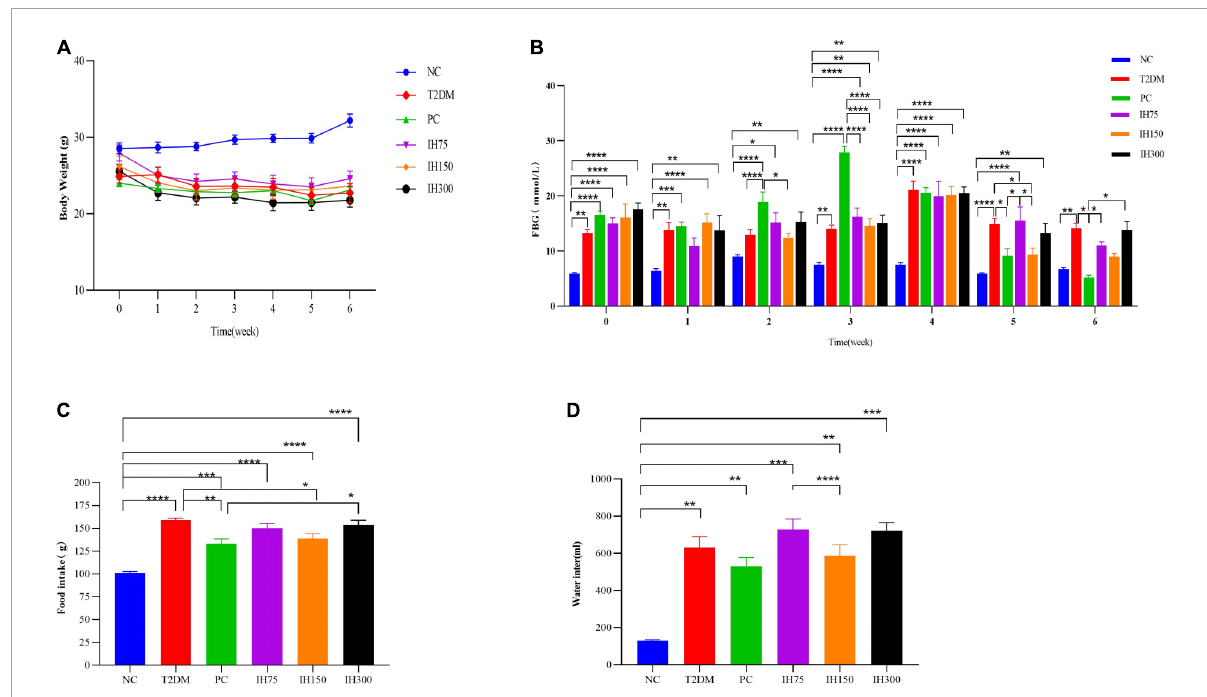
FIGURE1 Effects of isorhamnetin (IH) on body weight (A) , fasting blood glucose (B) , food intake (C) , and water intake (D) in mice. All data are expressed as mean ± standard error of the mean (SEM). N = 6, P < 0.05 (*), P < 0.01 (**), P < 0.001 (***), and P < 0.0001 (****).